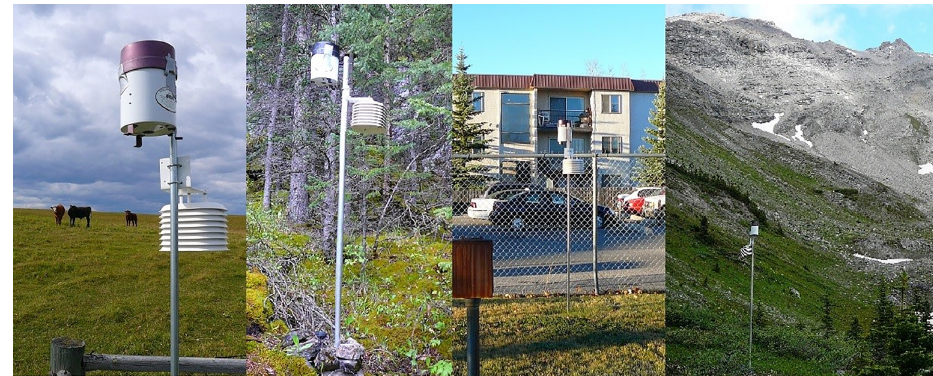
Figure 2. Site location examples: prairie, forest, urban, and mountain.